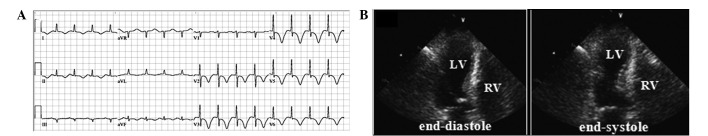
Left ventricular involvement of Takotsubo cardiomyopathy during recurrence. (A) Electocardiogram and (B) echocardiographic images. LV, left ventricle; RV, right ventricle.